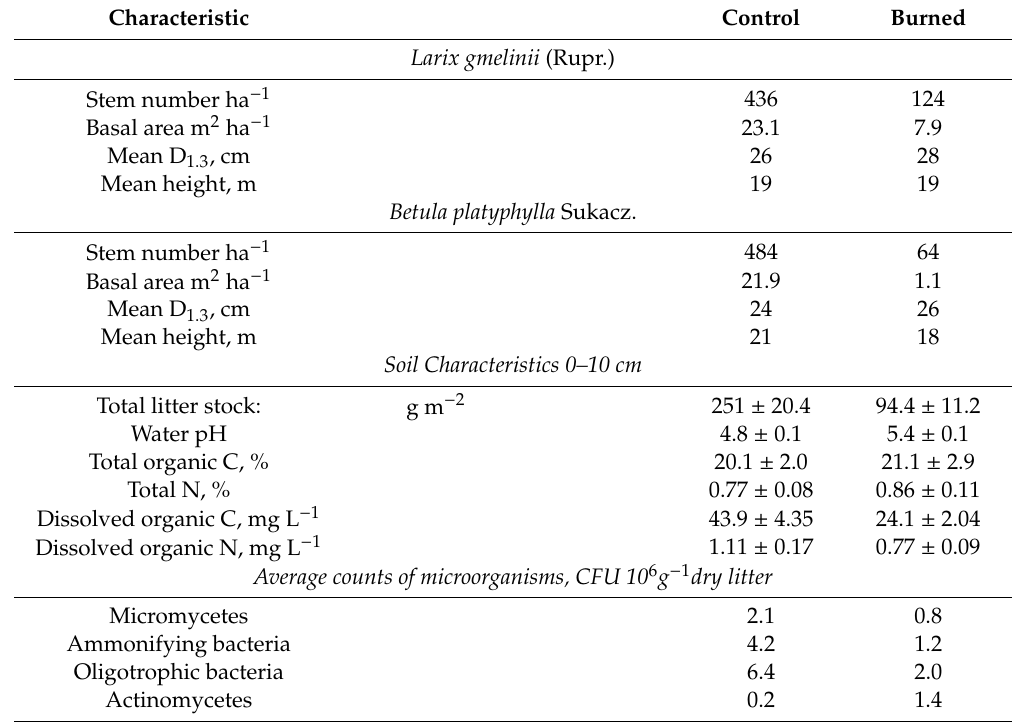
Table 1. Stand, soil, and litter